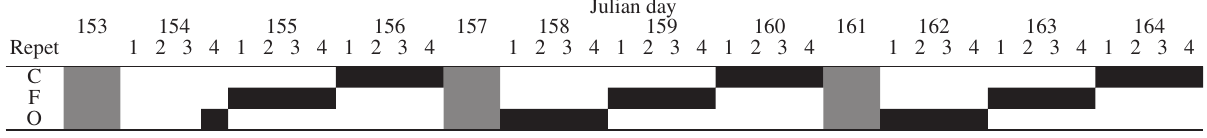
Table 1. – Sampling schedule during the VARIMED-95 cruise. The grey shadowed columns correspond to days dedicated to obtaining quick hydrographic surveys along the transect shown in Figure 1. The black zones correspond to biological sampling, generally repeated four times per day: 1) early morning, from 6 to 8.30 h; 2) midday, from 11.30 to 13.30 h; 3) evening, from 17 to 19 h; 4) night, around 22